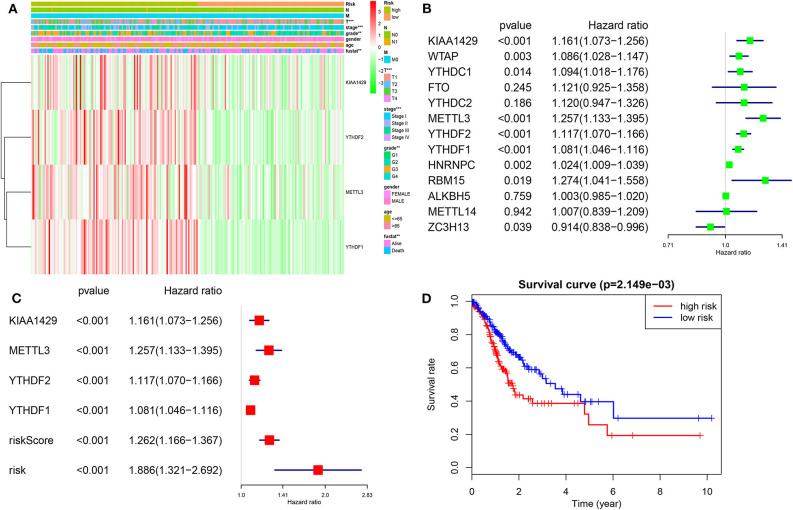
Interaction among m6A RNA methylation regulators and pathway analysis of HCC in cluster1/2 subgroups. (A) The m6A modification-related interactions among the 11-m6A RNA methylation regulators. (B) Spearman correlation analysis of the 13-m6A modification regulators. (C–H) GSEA revealed that genes with higher expression in cluster1 subgroup were enriched for hallmarks of malignant tumors.